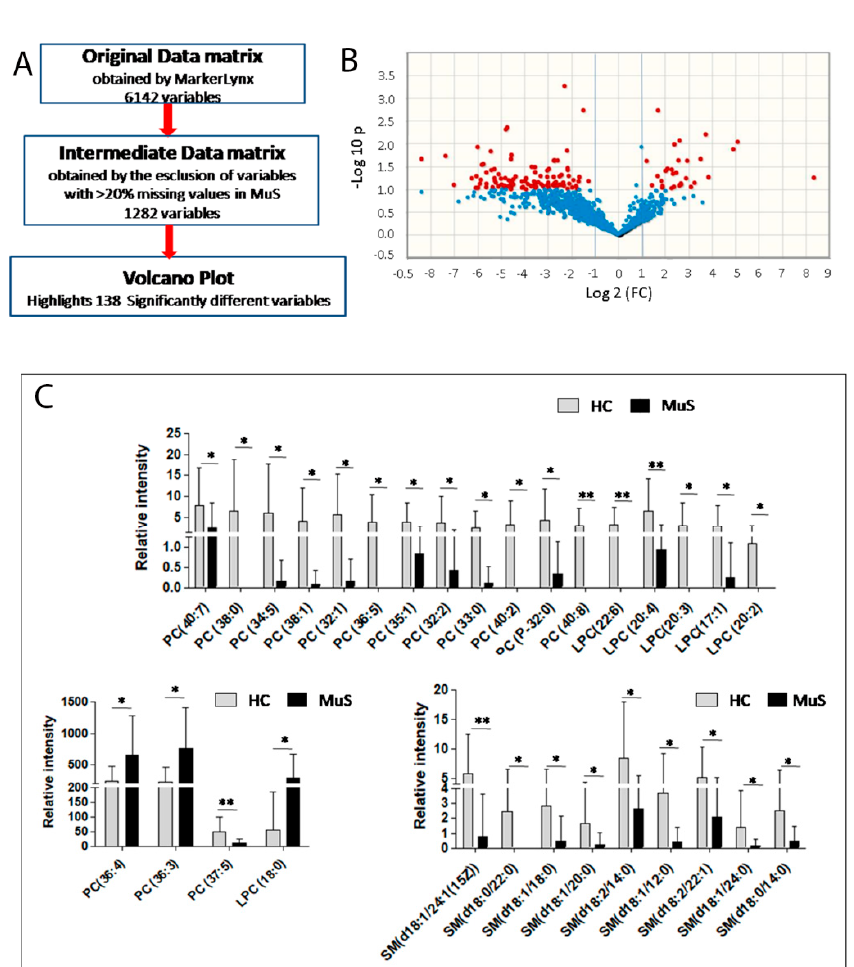
Figure 3. Lipidomic profiling in tears and sera from MuS patients. ( A ) Workflow description for tears lipidomics data processing. ( B ) Figure shows the Volcano Plot: a combination of fold change (FC) and t -tests. The x-axis is log2 FC and the Y-axis is log10 ( p -value) obtained by non-parametric test. The red dots are significant with the -log10 ( p -value) > 1. The red dots on the right represent the lipids with higher levels in MuS patients, while the dots on the left are the lipids with lower levels in MuS tears in respect to HCs. ( C ) In the histograms the relative abundance of the tear identified significantly different phospholipids (divided into 15 PCs, 6 LPCs and 11 SMs) is reported. In the grey bars the mean and SD of control group are reported, while in black bars the mean and SD of the MuS patients are reported. * means p < 0.05 and ** means p < 0.01 at the Student’s t -test or Mann Whitney U-test.